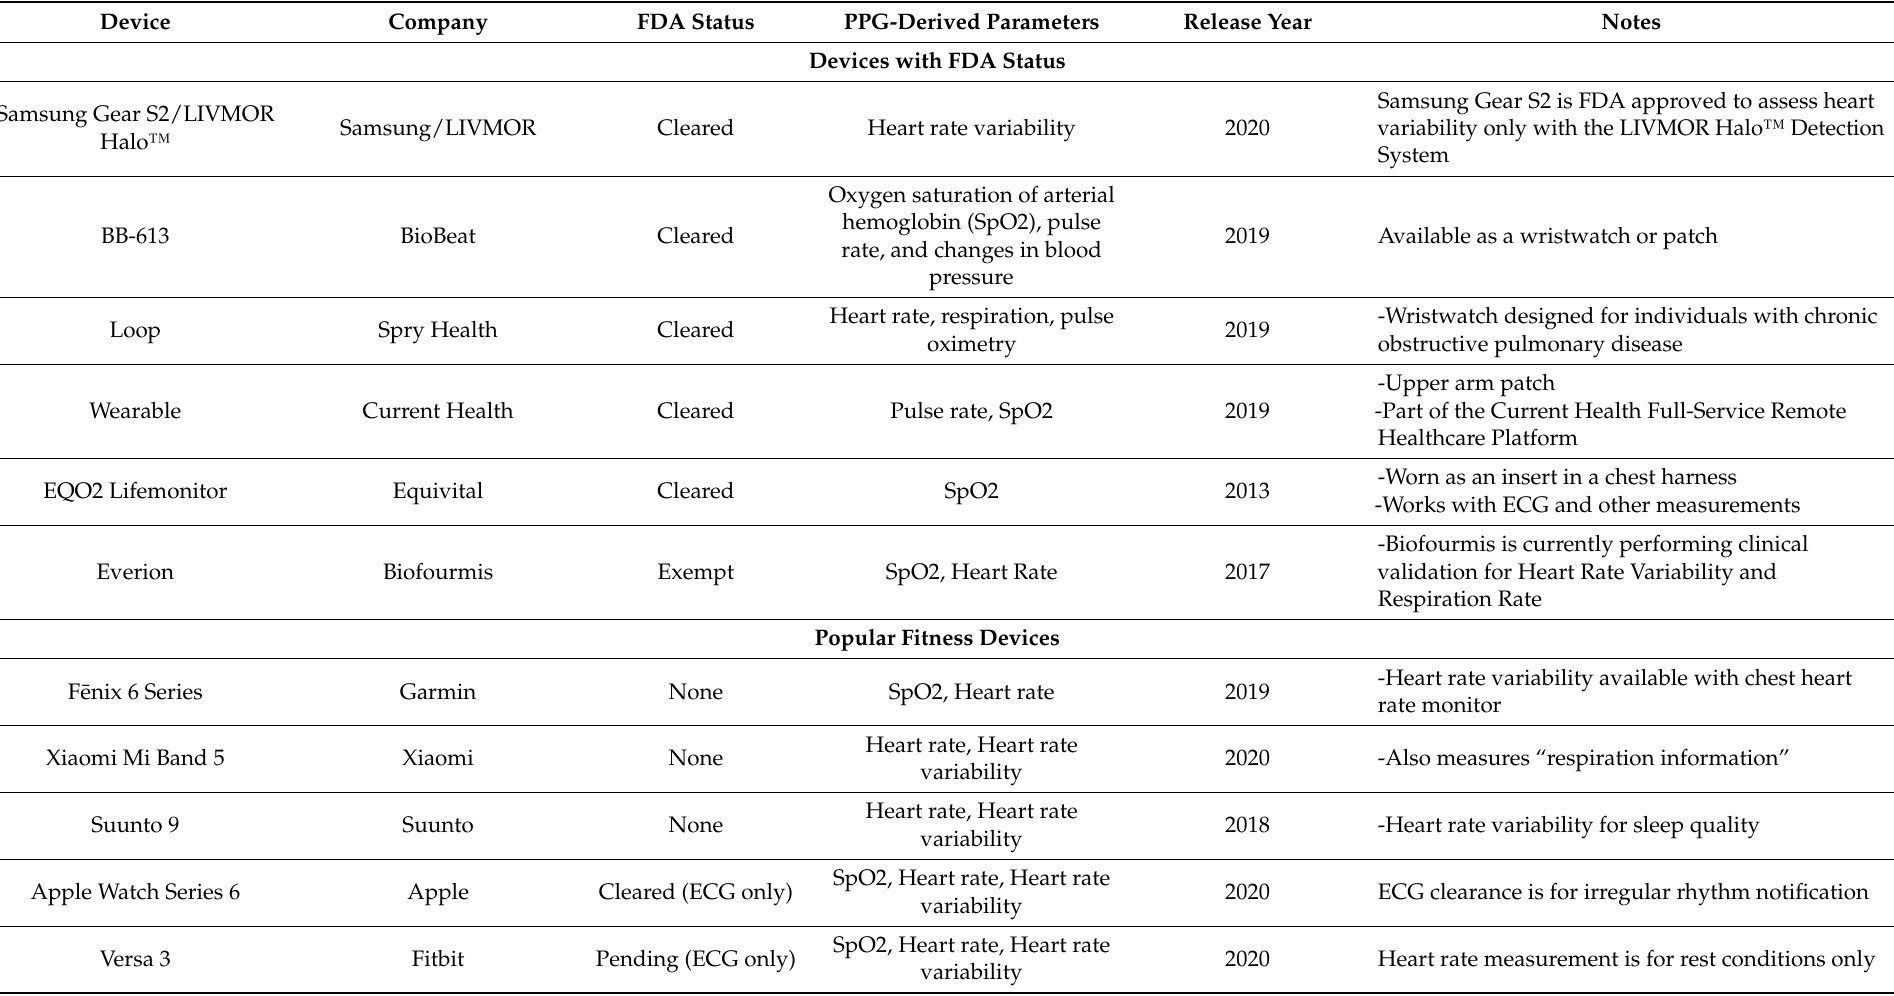
Table 1. PPG-based remote and continuous/intermittent monitoring (RCIM) devices with Food and Drug Administration (FDA) status and popular fitness